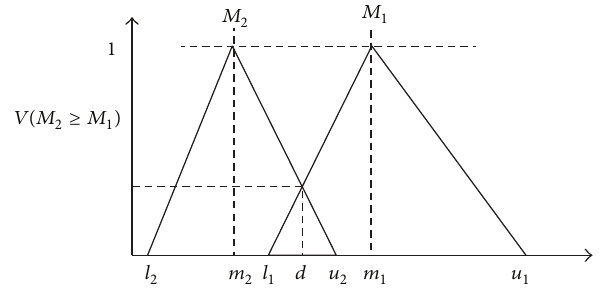
Figure 4: The intersection between 𝑀 1 and 𝑀 2